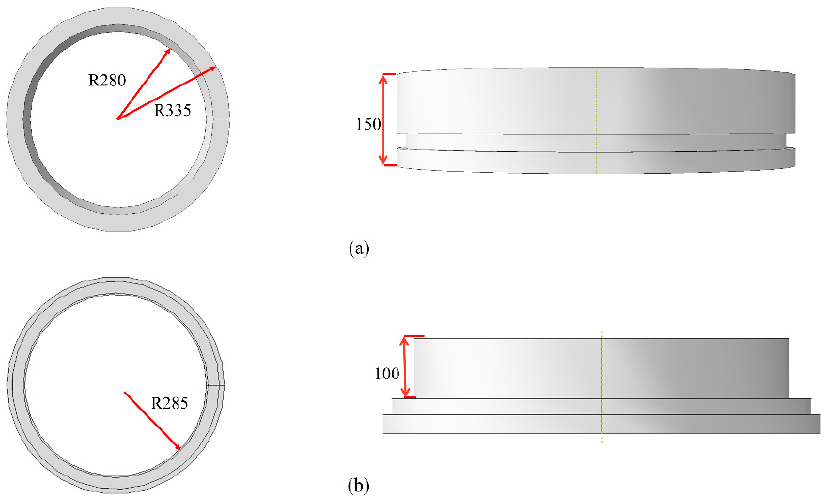
Table 1. Mechanical properties of aluminum alloy 2A70.